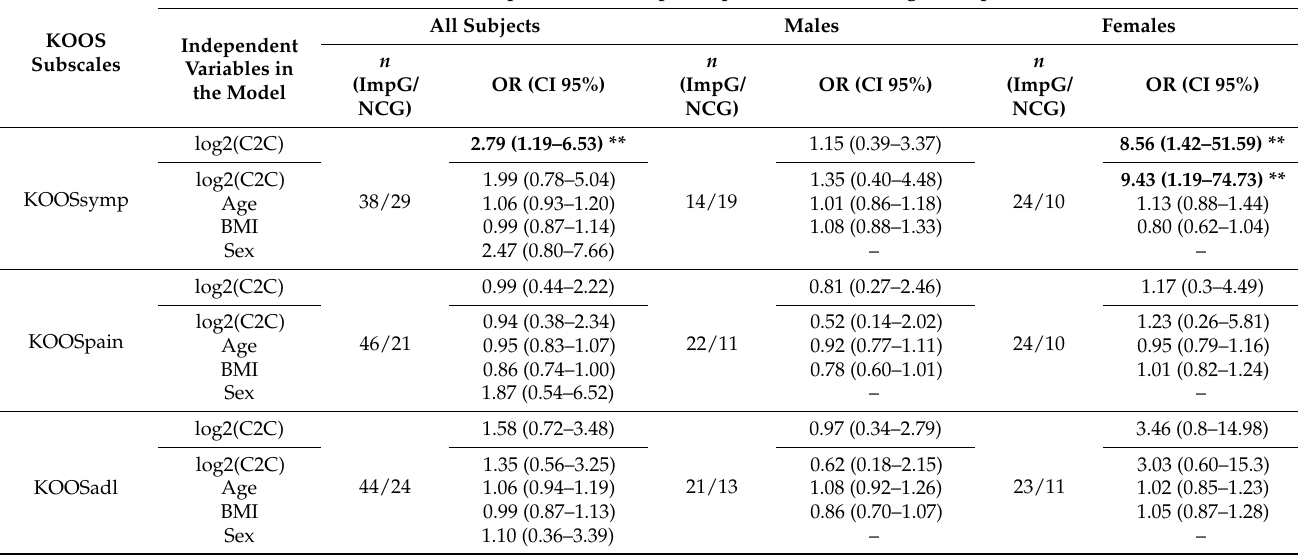
Table A4. The prediction of improvement in different KOOS subscales by preoperative uC2C values (generalized linear models